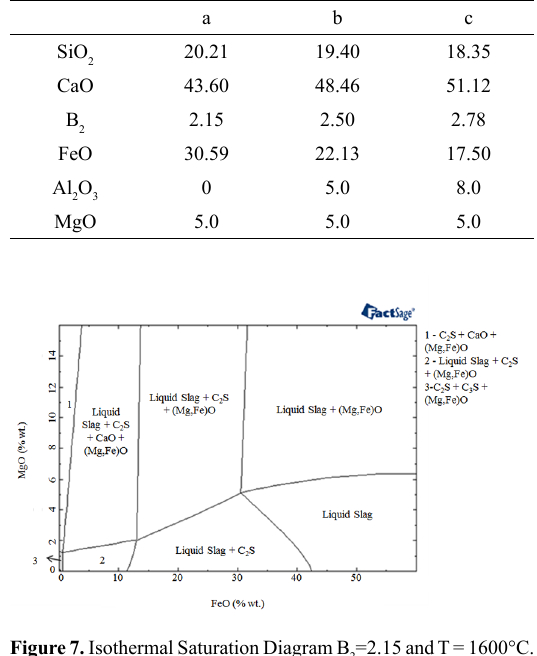
O and 5% MgO. 2 3